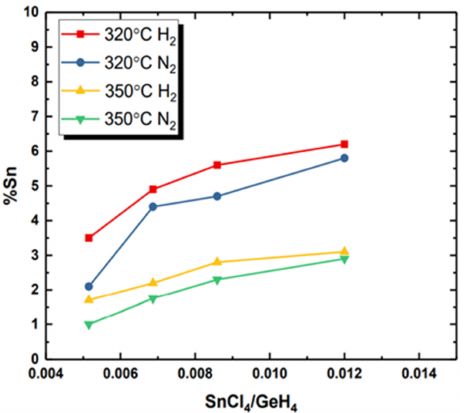
Figure 12. Sn content vs. SnCl 4 /GeH 4 ratio (growth temperatures: 320 and 350 ◦ C; carrier gases: N 2 and H 2 ; precursors: GeH 4 and SnCl 4 ). Reproduced from [153], open access by ASU